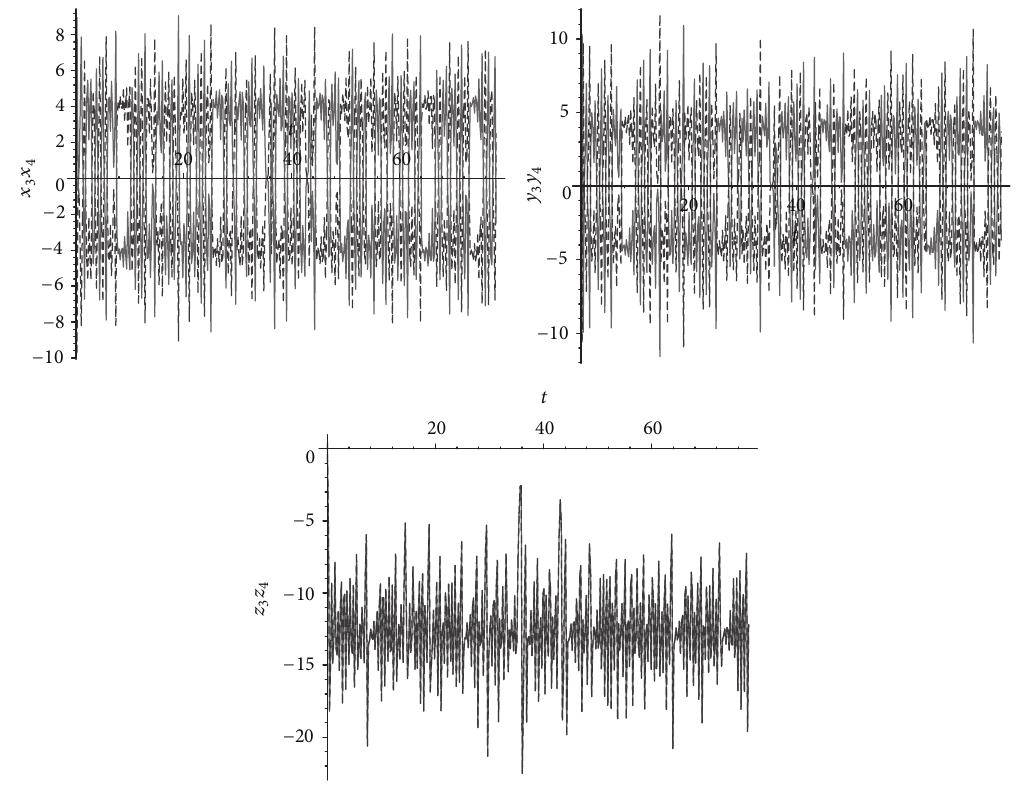
Figure 12: The temporal evolution of variables between node 3 (“ ⋅⋅⋅ ”) and node 4